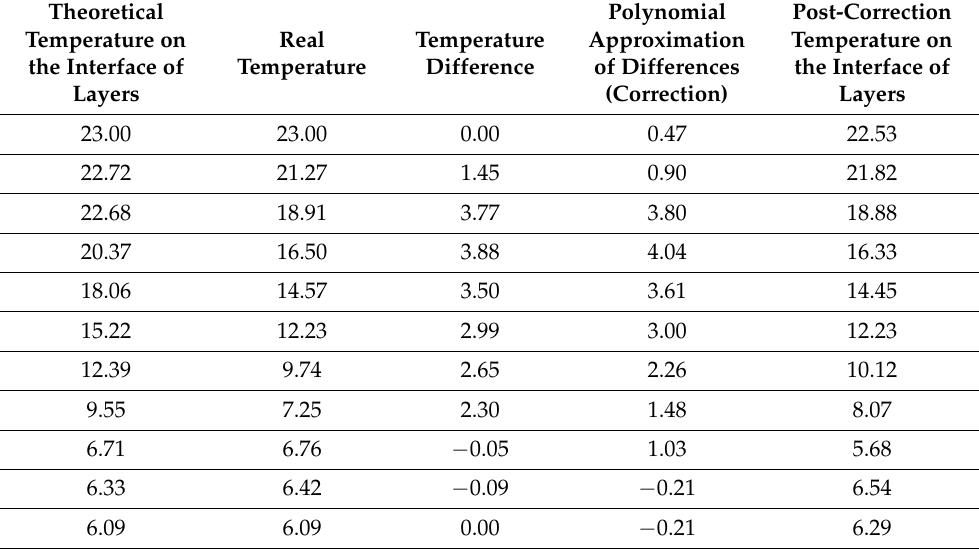
Table 6. Polynomial approximation of the temperature